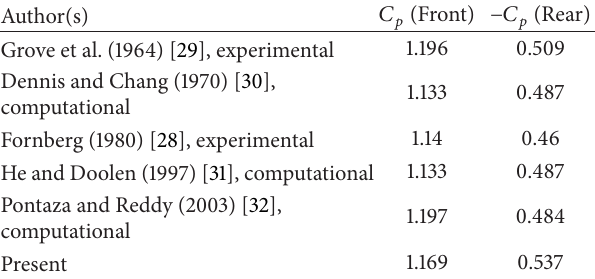
Table 1: Comparison of pressure coefficient at the front and rear stagnation points with previous